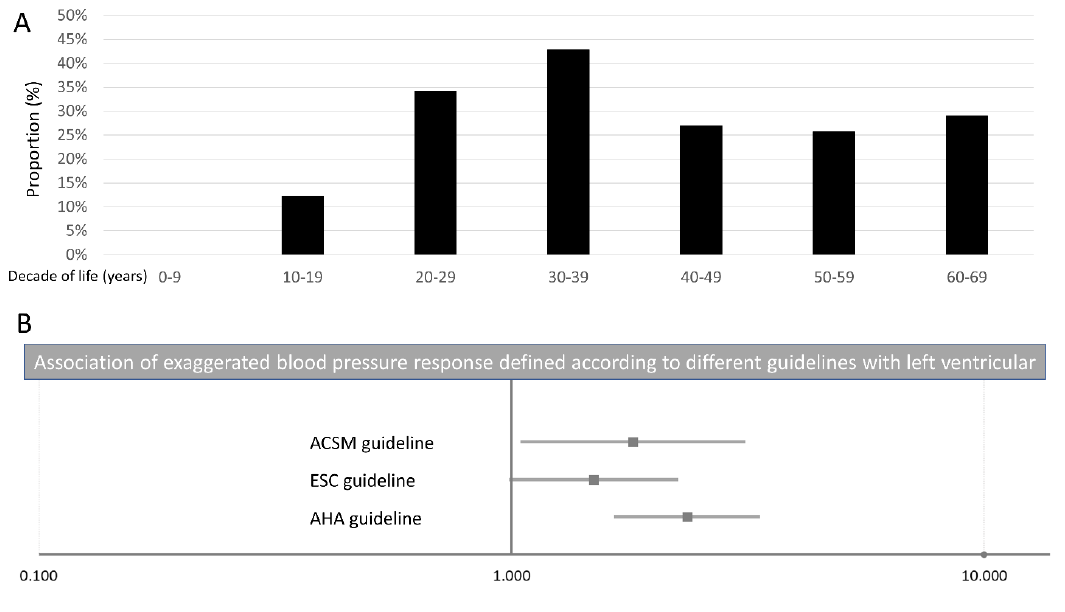
Figure 2. Exaggerated blood pressure response and left ventricular hypertrophy. Panel ( A ) Proportion of left ventricular hypertrophy stratified for age by decades. Panel ( B ) Association of exaggerated blood pressure response according to AHA, ESC, and ACSM guidelines with left ventricular hypertrophy. Table 4. Association between of exaggerated blood pressure response, blood pressure values at rest, and maximum value during exercise on the one hand and left ventricular hypertrophy on the other hand (univariate and multivariate logistic regression model).